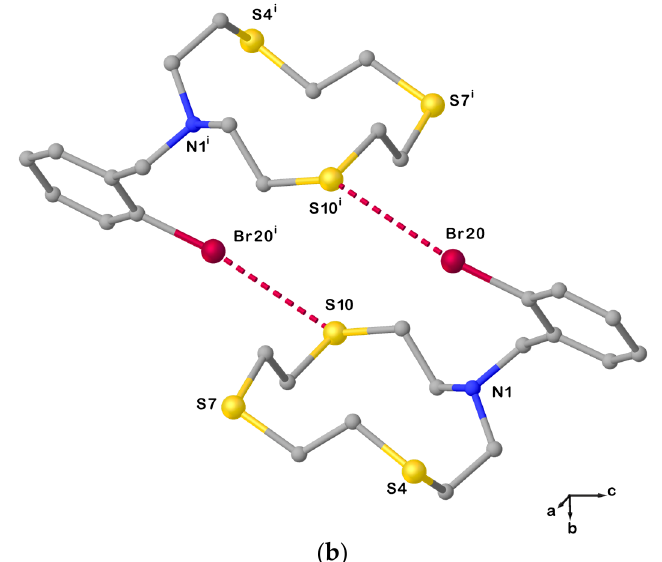
Figure 4. ( a ) View of the asymmetric unit of L20 with the atom-labelling scheme adopted. Hydrogen atoms have been omitted for clarity. Displacement ellipsoids are drawn at 50% probability level; ( b ) X-bonded dimeric arrangement found in L20 with the numbering scheme adopted. S10···Br20 i = 3.5030(3) Å; C19 − Br20···S10 i = 163.6(1) o ; and symmetry operation: i = − x, 1 − y, − z. For selected bond lengths (Å) and angles ( o ), see Table S3 in the Supplementary Materials.